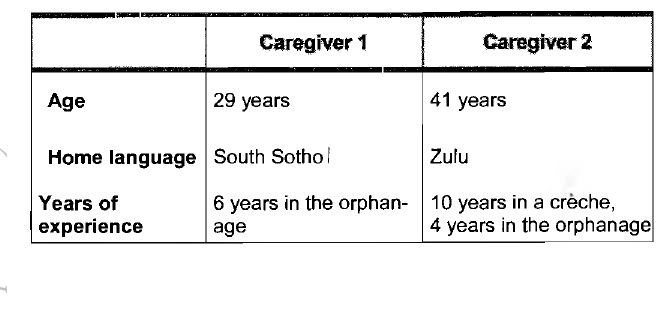
Table 1: Characteristics of the